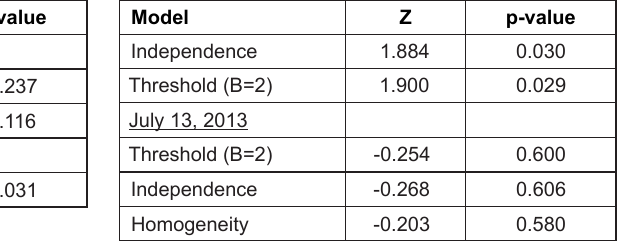
Table 27. Tests for randomness of collared caribou for the Cape Bathurst 2006 data